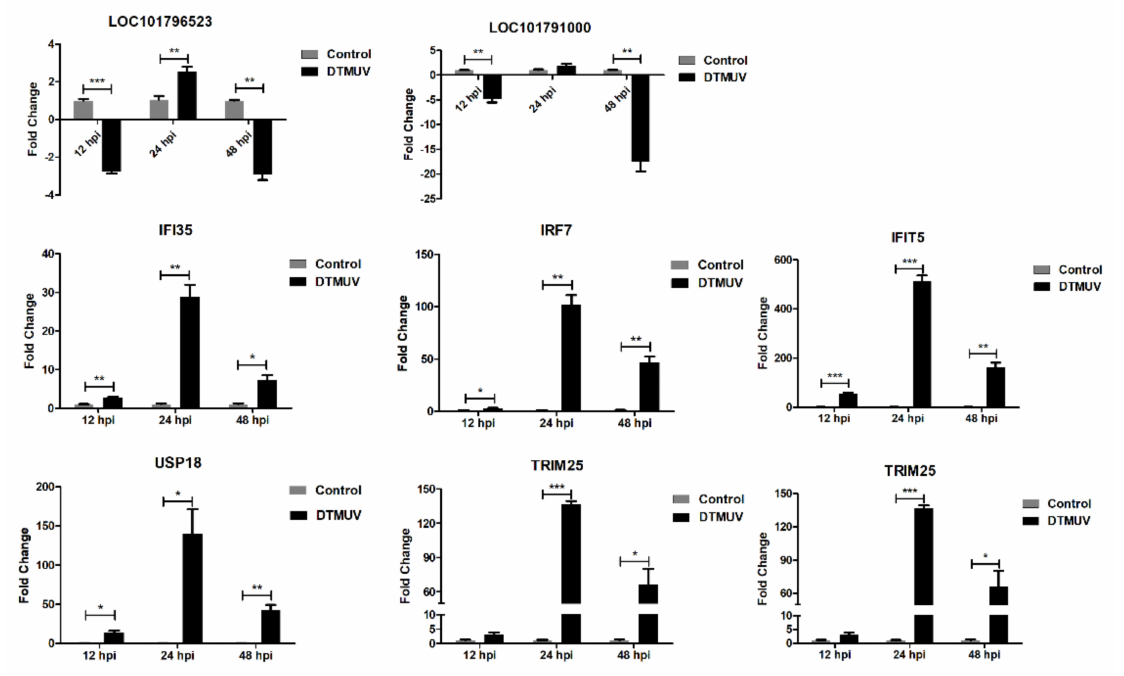
Figure 8. Validation of RNA-seq by qRT-PCR. The X-axis represents hours post infection (hpi). The Y-axis represents fold change. * means p ≤ 0.05, ** means p ≤ 0.01, *** means p ≤